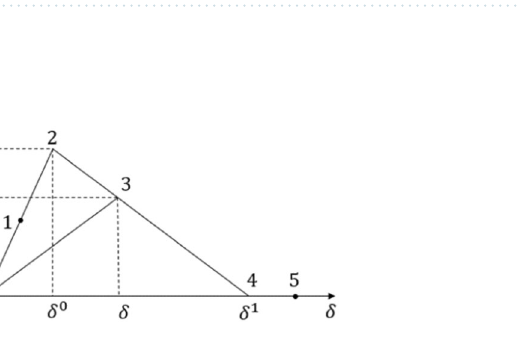
Table 3. Summary of test results.